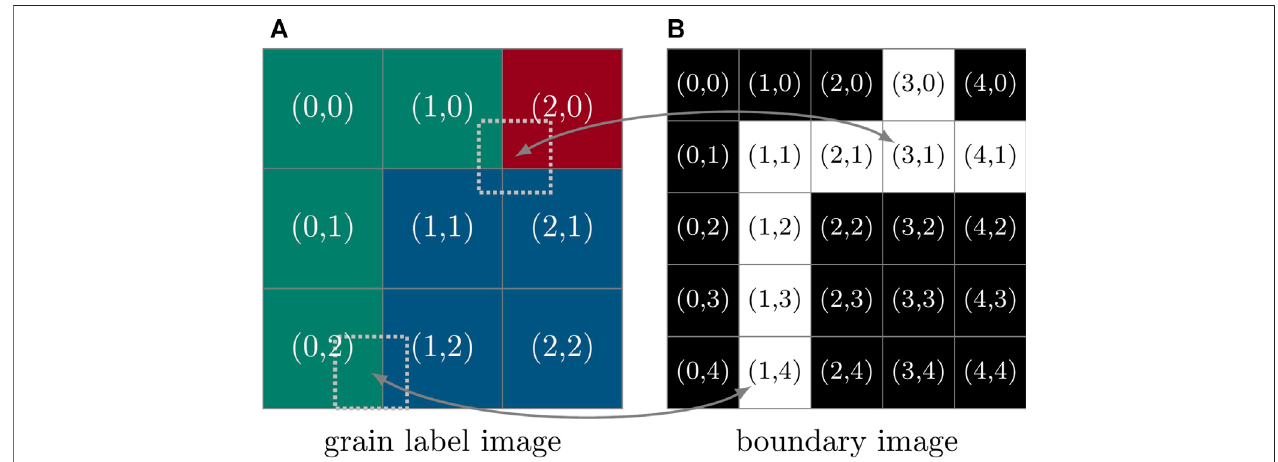
FIGURE 5 | Two-dimensional example of (A) a 3 × 3-pixel grain label image I sim with three grain labels (green, red and blue) and (B) its “ subvoxel ” boundary image I b . Two pixels of the boundary image (one at location (3, 1) and another at (1, 4)) are superimposed on their corresponding locations in the grain label image (dotted squares). Effectively, the set N b (·) contains all grain labels covered by these shifted pixels. The cardinality of the set N b (( 1 , 4 )) is therefore 2, whereas # N b (( 3 , 1 )) (cid:1) 3. If the indices specifying the location of a pixel in the boundary image are all even, this pixel lies entirely within the bounds of a single pixel in the grain label image; consequently, the cardinality of N b (·) is always 1, and the pixel in I b will always be assigned the value of zero (shaded black in the boundary image).